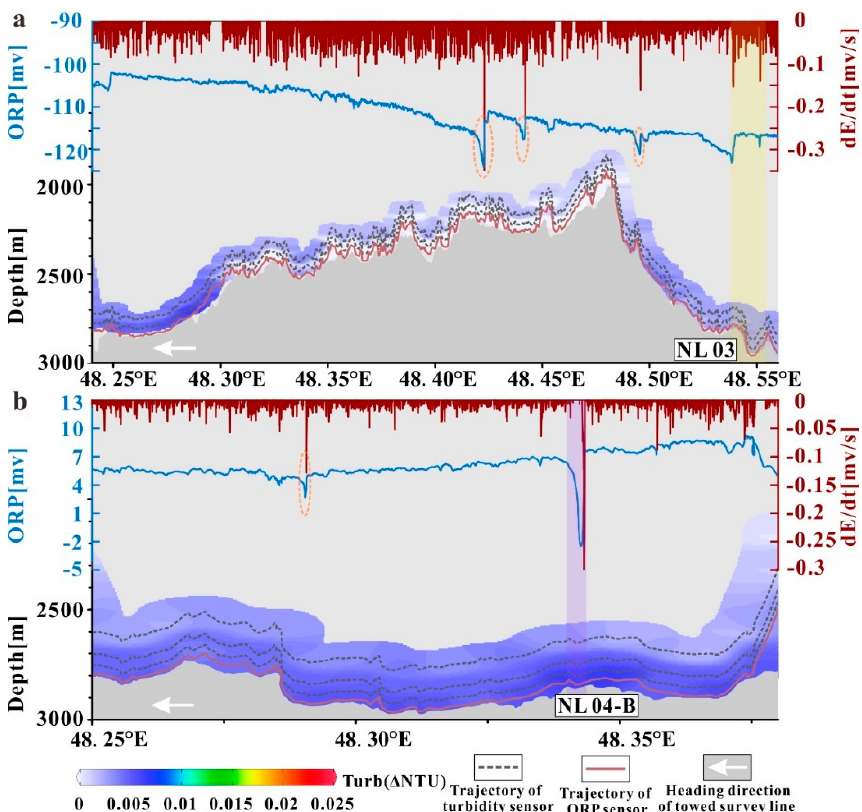
Figure 3. Hydrothermal plume distribution along DHDS lines. ( a , b ) The seafloor relief, Δ NTU, ORP and negative dE/dt along lines NL03 and NL04-B, respectively. The top blue line is ORP and the top brown line is dE/dt. Note that the orange dotted ellipses are the incorrect records from the ORP sensor caused by the towed body hitting the seafloor. The yellow band indicates an inferred hydrothermal anomaly site, and the purple band indicates a suspected one. Both panels use the same colorbar and legend.